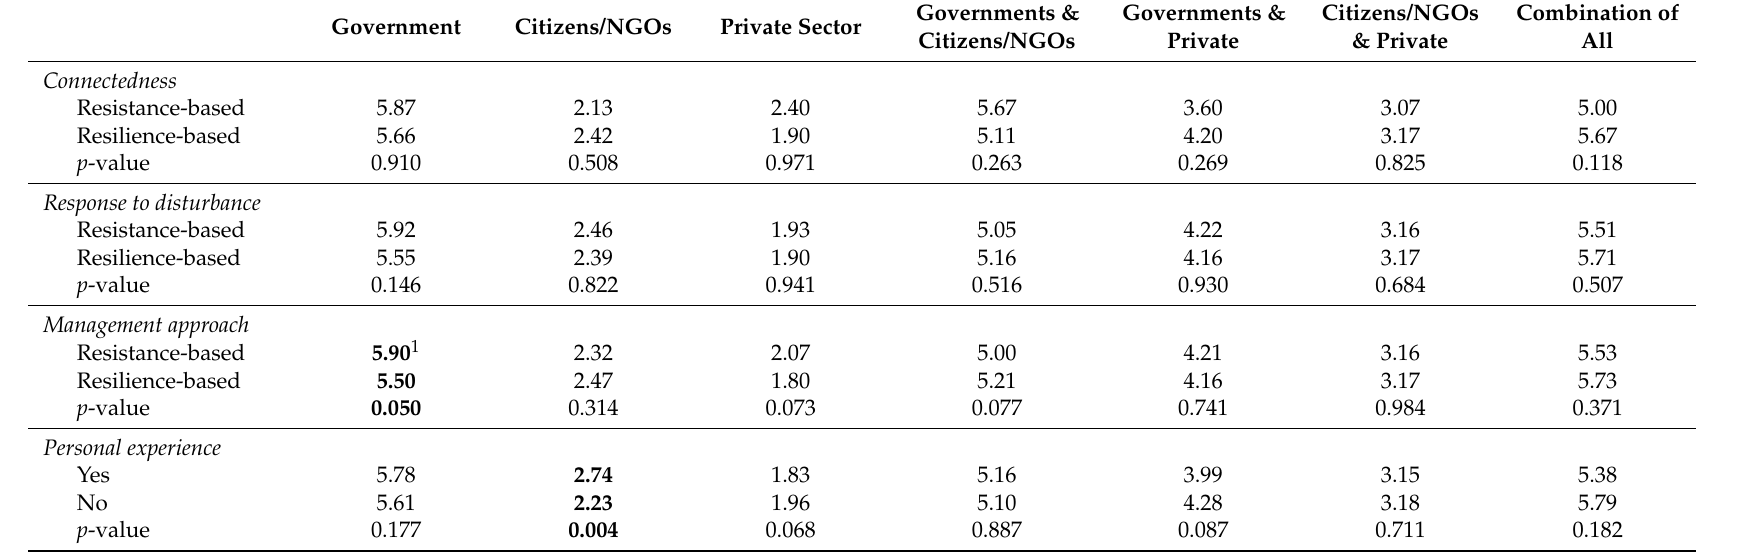
Table 3. Average desirability ratings for governance actors by resilience/resistance-based internal representations of the system. Government Citizens/NGOs Private Sector